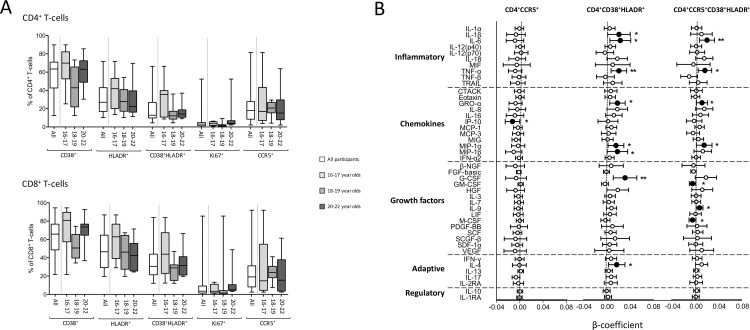
Comparison of CD4+ T-cell activation markers by age categories in in AGYW.A. The overall expression level for all participants are represented by the white bars, and the grey bars represent the expression levels split according to age. Mann Whitney U-tests were used to compare groups and a p value of ≤0.05 was considered significant. B. Linear associations between the different cytokines and frequencies of activated CD4+ T-cells. Each association is shown as a β-coefficient and the error bars are the 95% confidence interval. Statistically significant associations are shown in black and p value of ≤0.05 was considered significant.